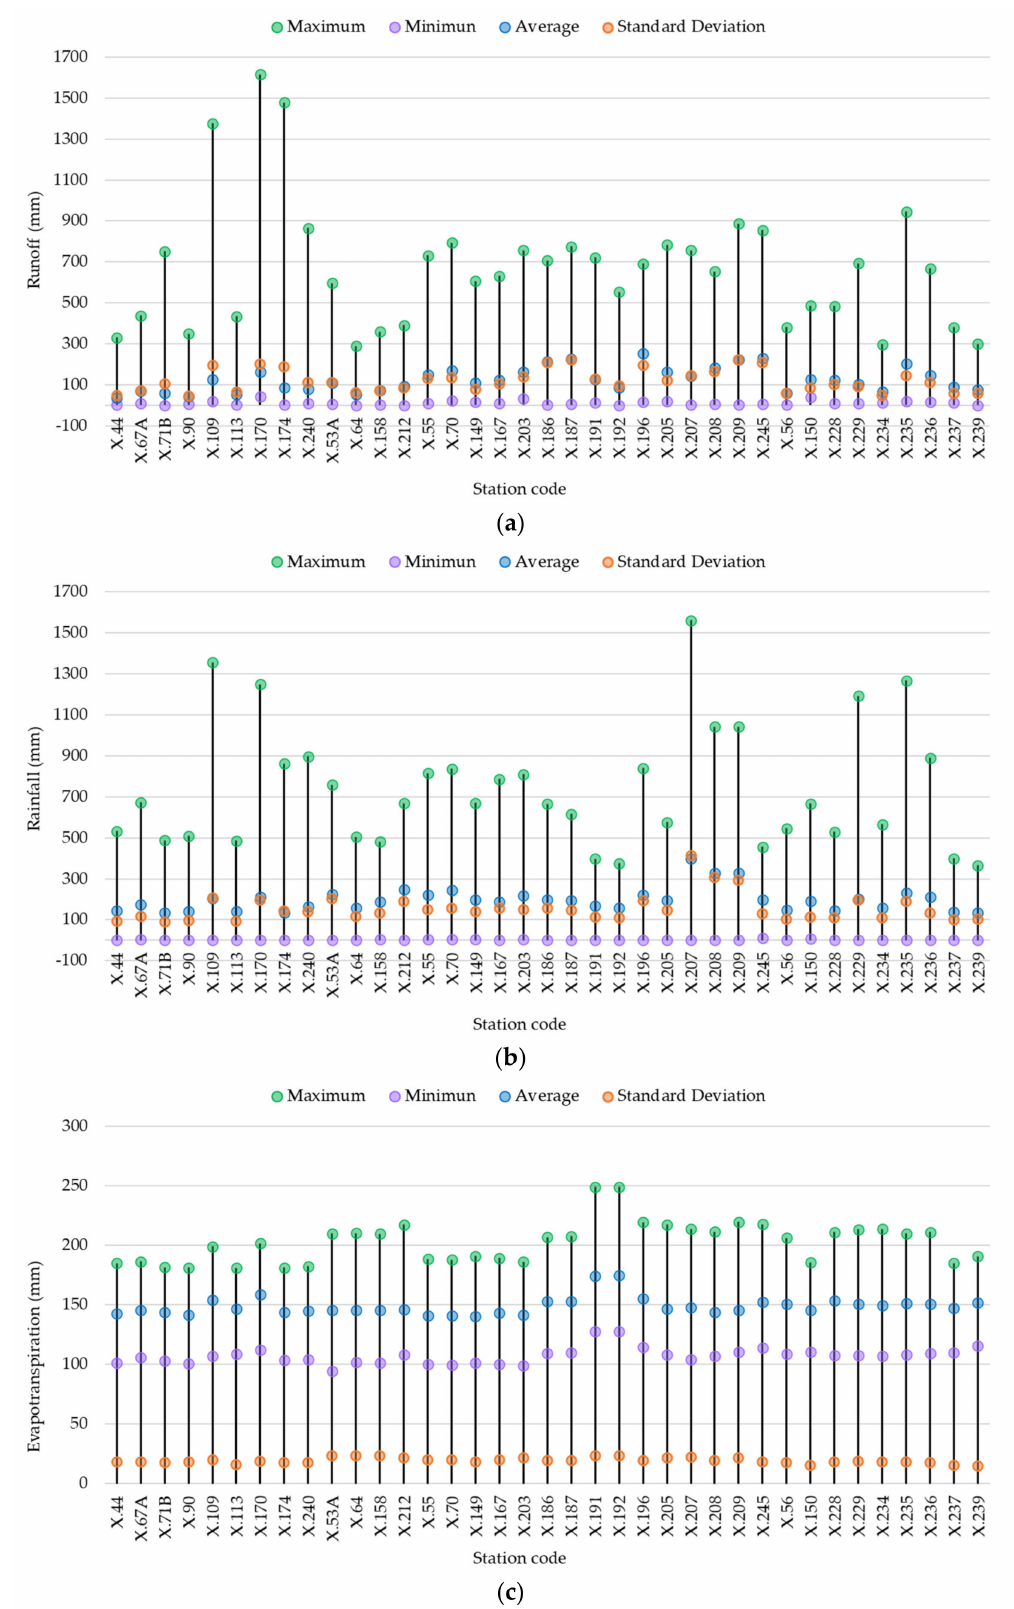
Figure 2. Statistical values of monthly ( a ) runoff, ( b ) rainfall, and ( c ) evapotranspiration data used in this